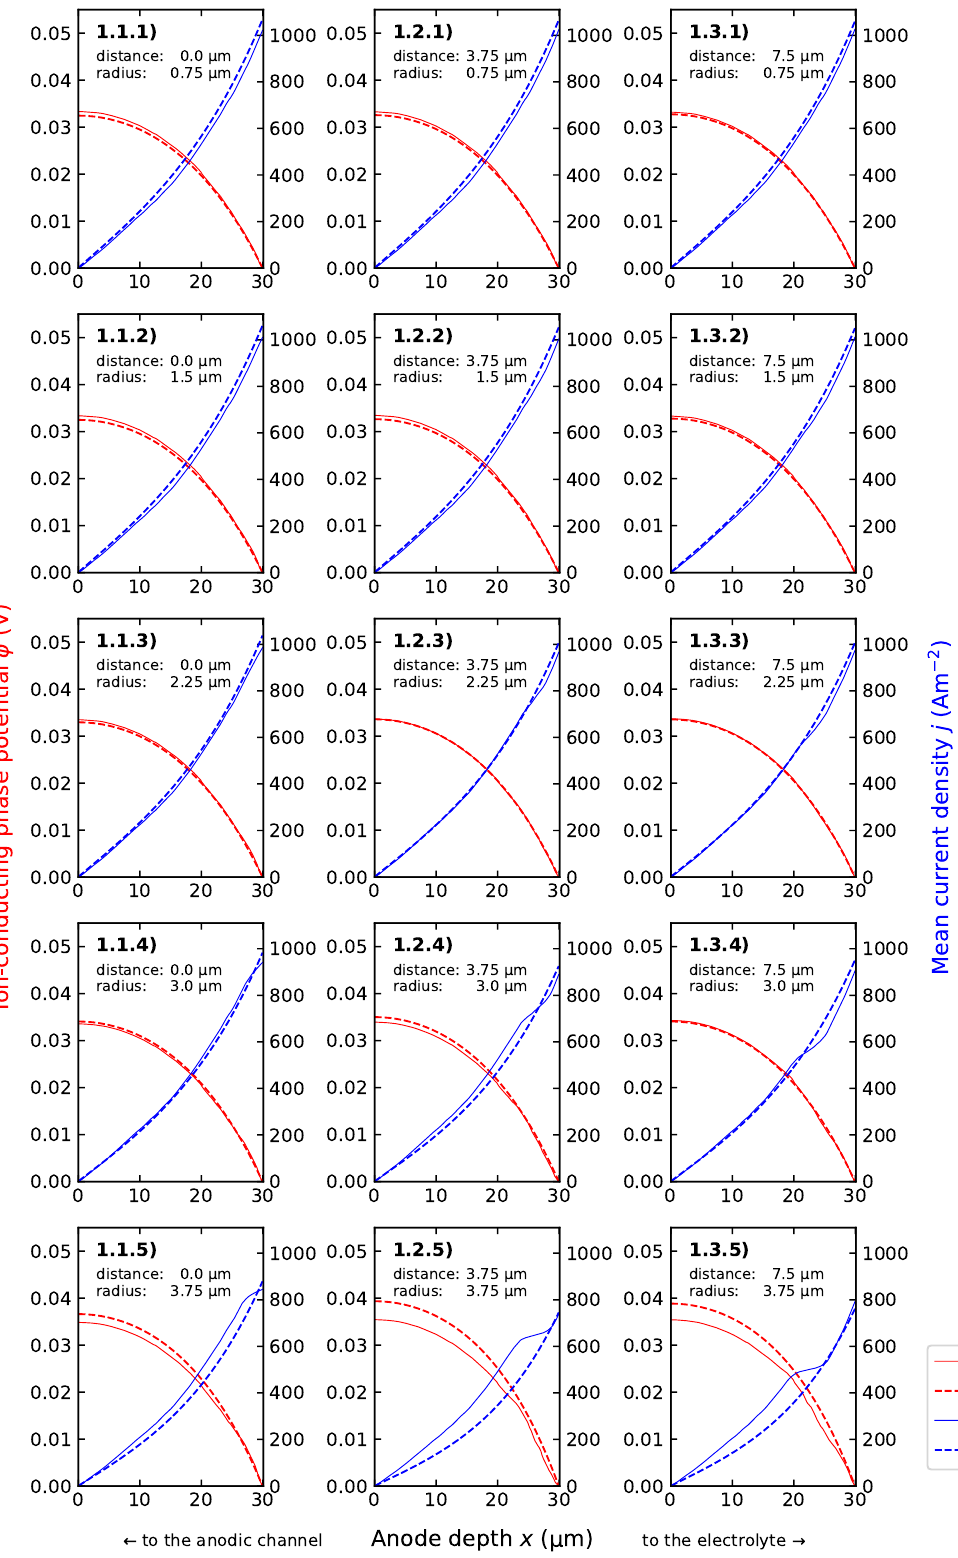
Figure 4. “Center-type” non-conducting disturbance parametric study: ionic potential and exchange current density fields. Boundary conditions: φ el,b = 0.05 V, p H 30.0µm. T = 1073